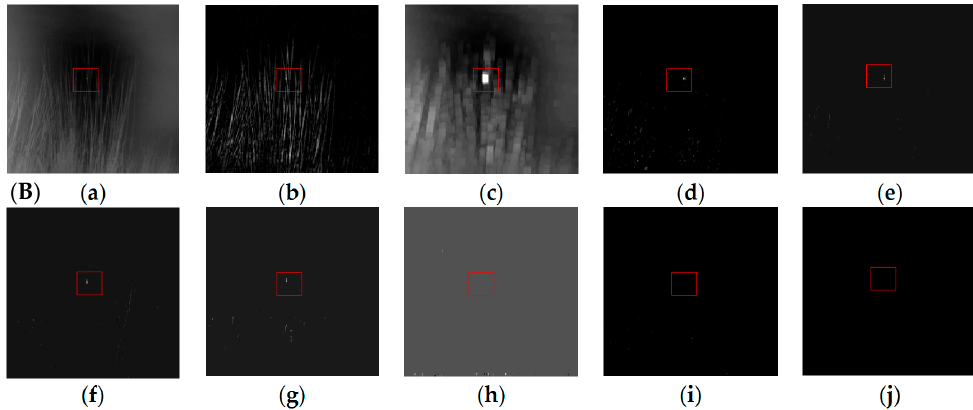
Figure 9. Results of different approaches to Scene 5 and 6. ( A ) Scene 5 (Sequence 5); ( B ) Scene 6 (Sequence 6); ( a ) Original image; ( b ) Tophat; ( c ) LCM; ( d ) MPCM; ( e ) IPI; ( f ) NIPPS; ( g ) ReWIPI; ( h ) SMSL; ( i ) RIPT; ( j ) NRAM.